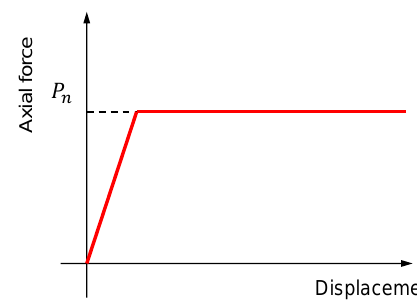
Figure 23. Compressive force-displacement relation of the knee brace member for push-over analysis.